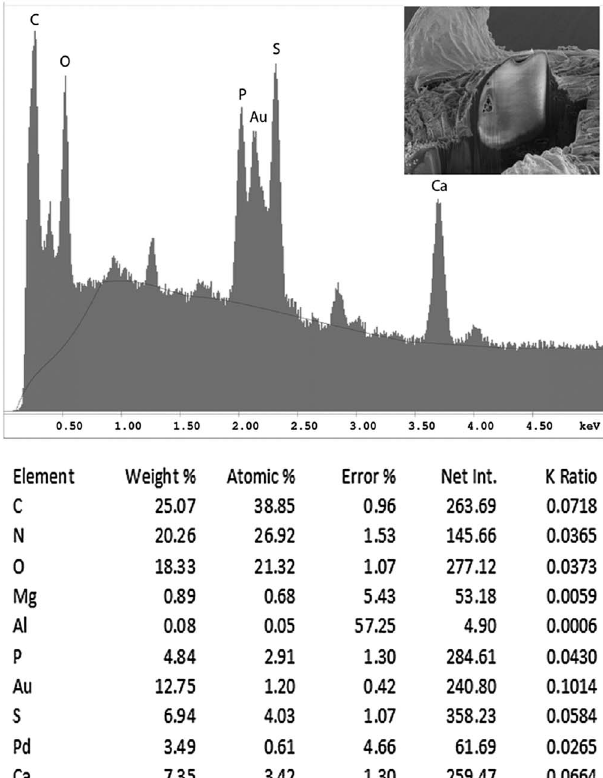
Figure 37. Energy dispersive X-Ray spectrum of the large anterior hook of a Neoechinorhynchus personatus specimen from Mugil cephalus in the Mediterranean showing high levels of phosphorus and calcium and low levels of sulfur. The X-ray data are the elemental analysis of the whole hook (see bolded fi gures in Table 3). Insert: SEM of a deep Gallium cut at the base of a hook.